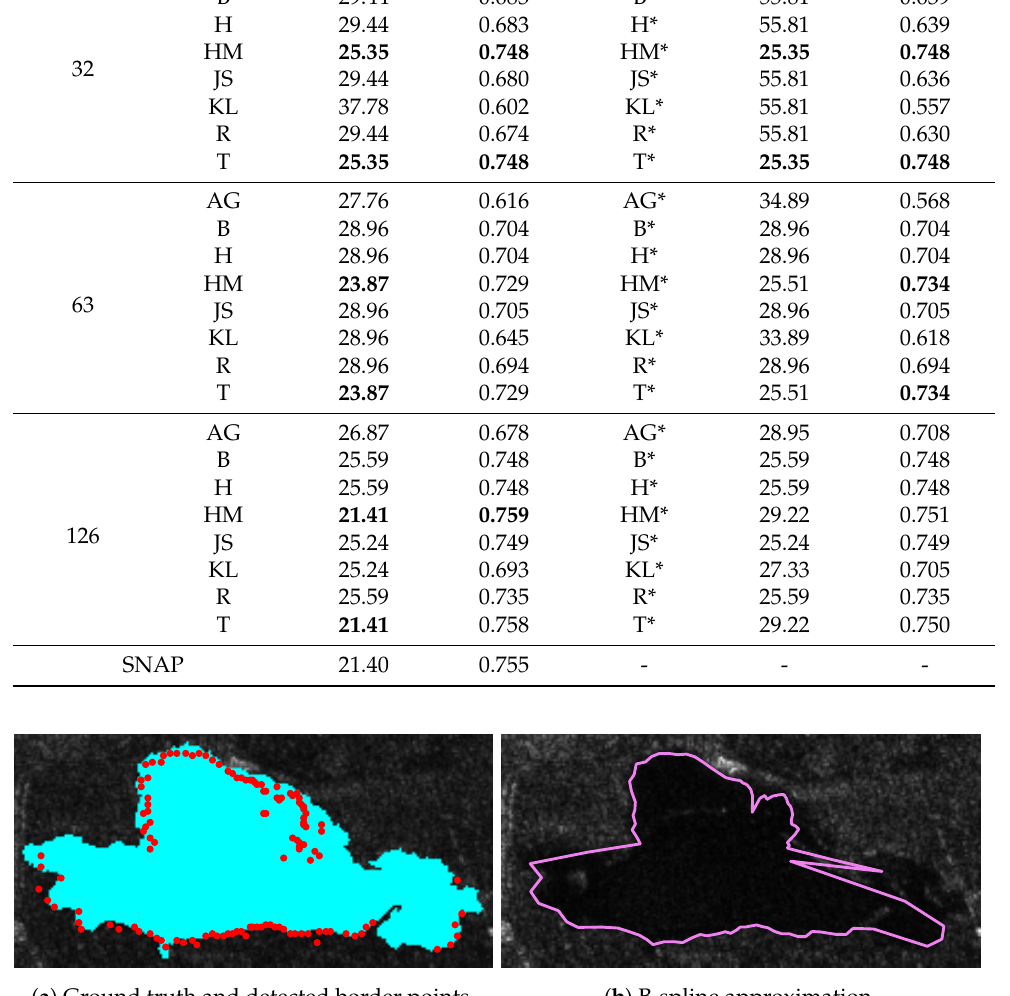
Figure 9. Results of HM with n r = 126 when the proposed algorithm is applied to the second lagoon in Figure 3 (left).